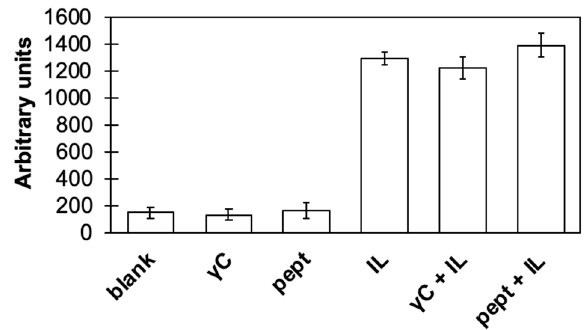
Figure 2. Effects on the Caco-2 transfected cell nuclear factor kappa B (NF κ B) pathway of γ C and of its peptides derived from simulated gastrointestinal digestion (pept). Experimental details are given in the text. Blanks are Caco-2 cells incubated alone (negative control), whereas IL are cells incubated with Interleukin 1 β (IL1 β ) (positive control). γ C and pept have been also been incubated in the presence of IL1 β (+IL).